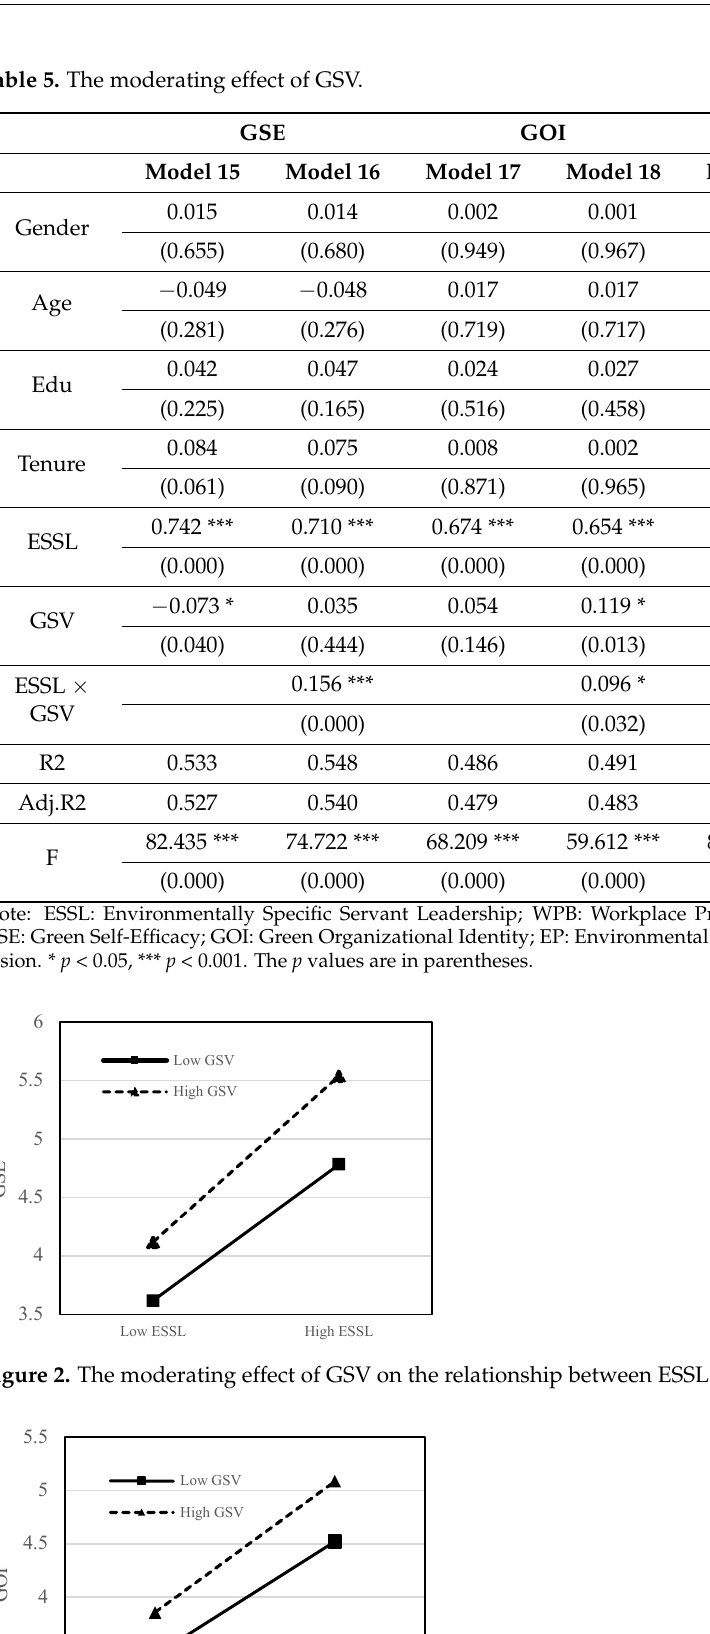
Table 5. The moderating effect of GSV.